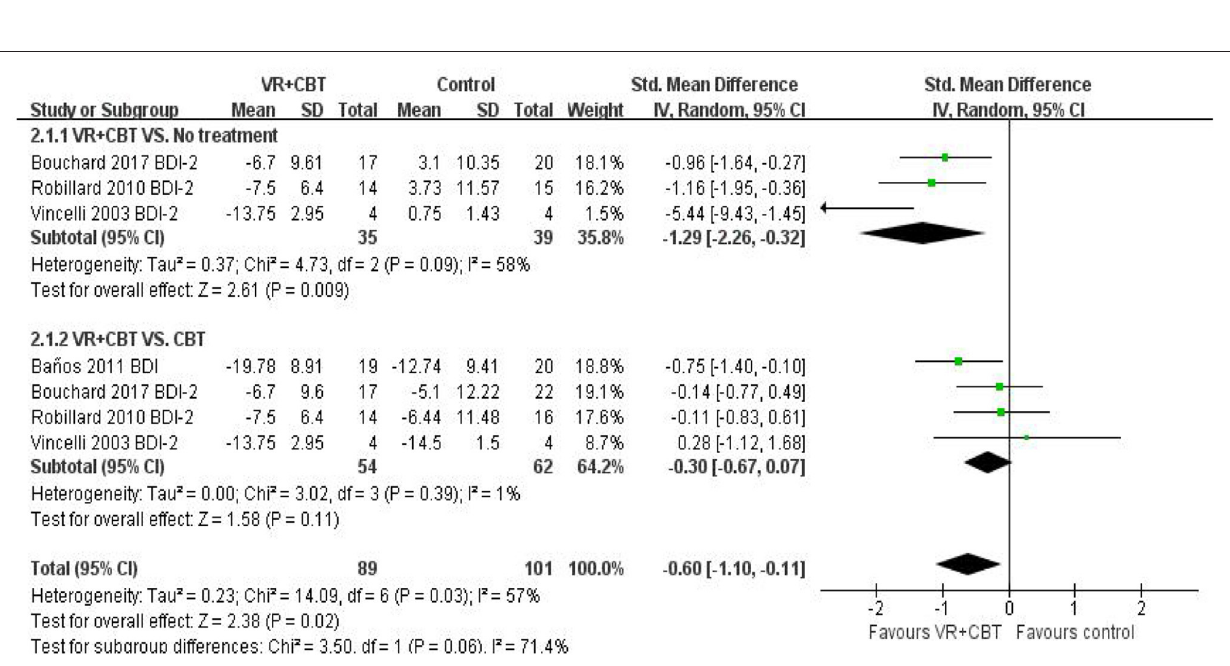
Frontiers in Psychiatry |